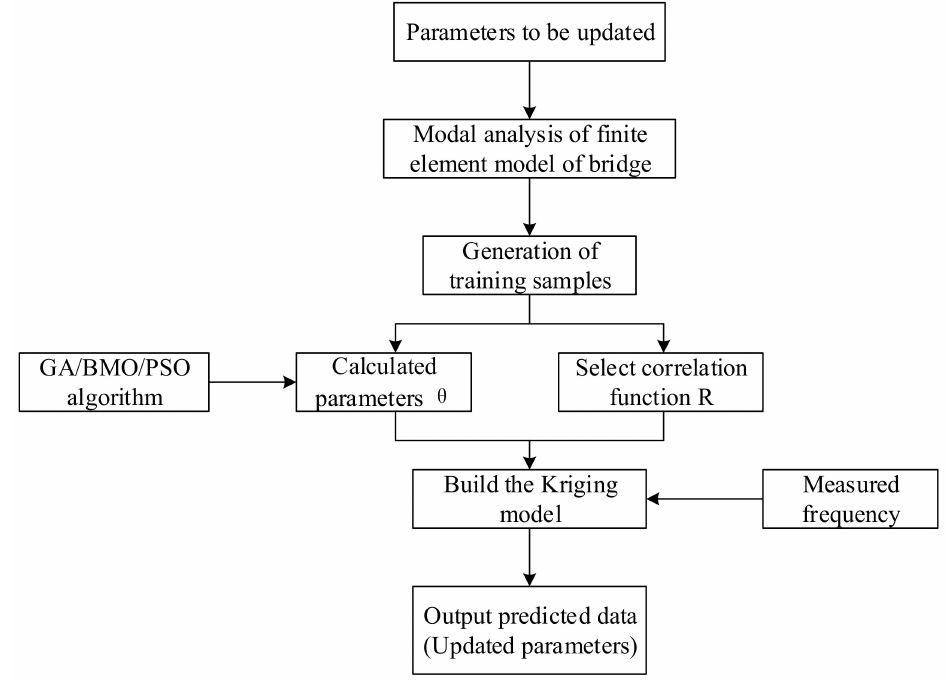
Figure 1. Kriging model-based finite element analysis model